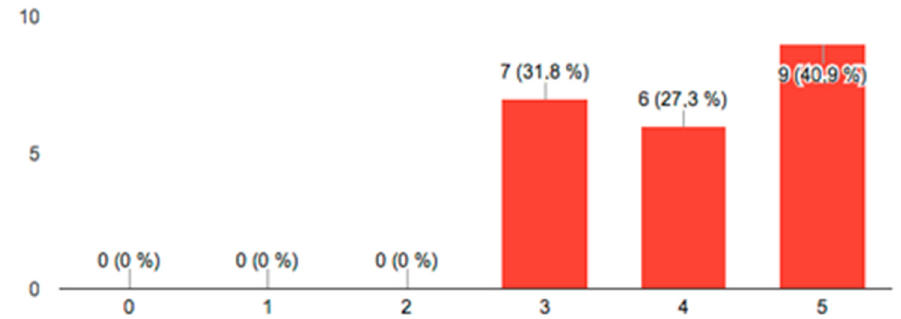
Figure 7. Ratings from 0 to 5 on the usefulness of the scanner as a diagnostic tool .